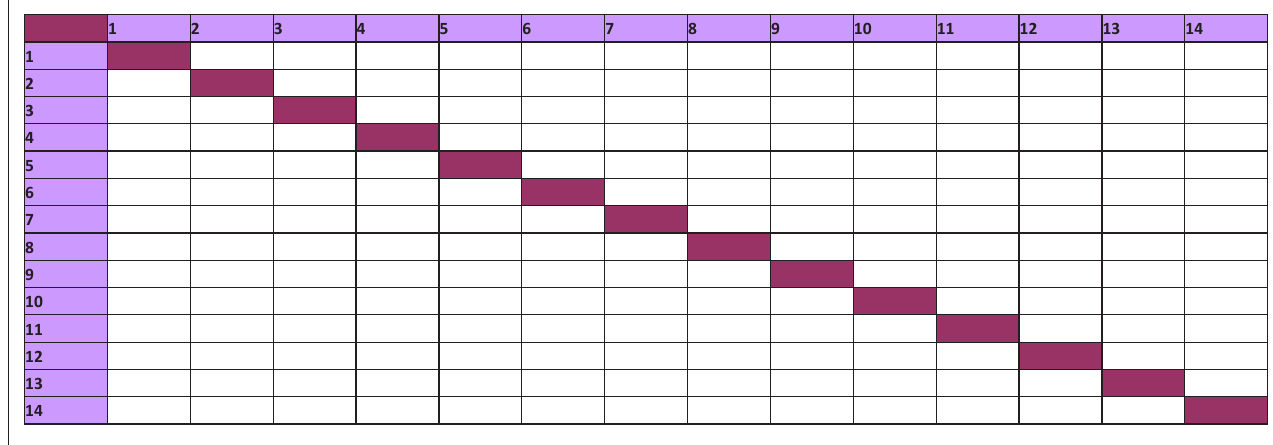
FIGURE 1: Tool used for pair-wise ranking of barriers and bridges.